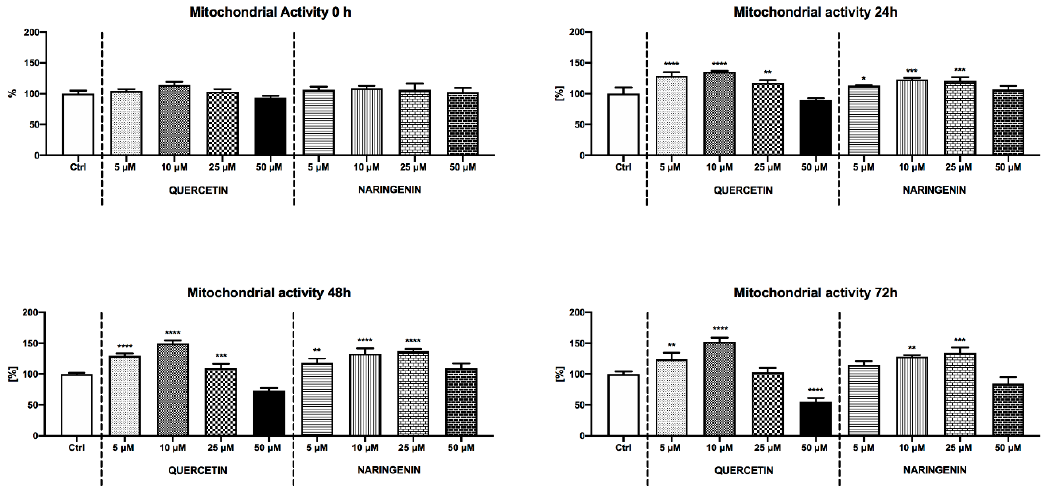
Figure 1. Mitochondrial activity of boar spermatozoa extended in the presence of quercetin or naringenin. Each bar represents mean ( ± S.D.) optical density as the percentage of the control, which was set to 100%, and the data are expressed as a% of the control value. The data were obtained from four independent experiments. Mean ± S.D. * p < 0.05; ** p < 0.01; *** p < 0.001; **** p < 0.0001. Table 2. Membrane integrity (%) of extended boar spermatozoa following exposure to quercetin or naringenin ( n =